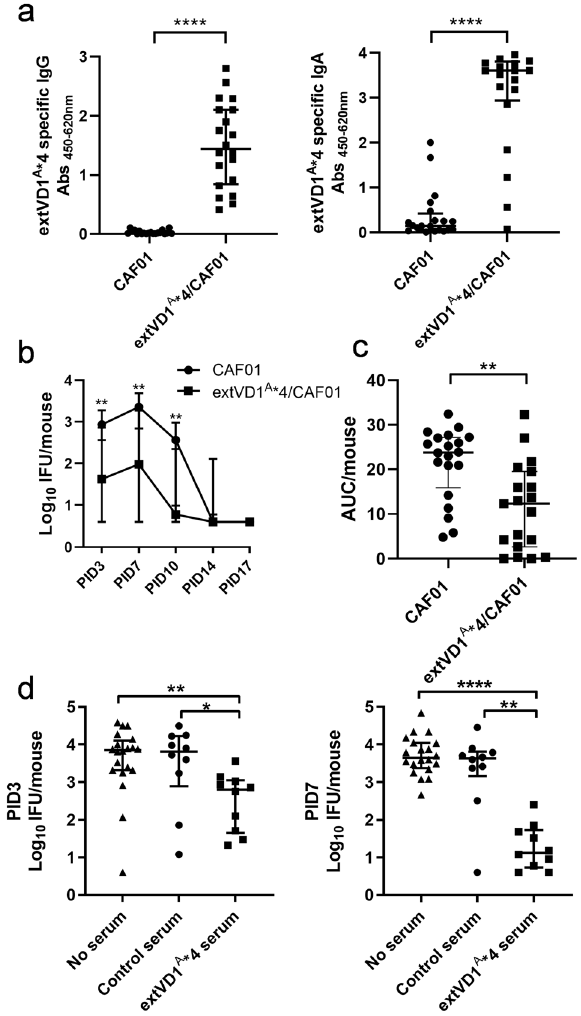
Fig. 4 Protective effect of extVD1 A *4/CAF01 induced immune responses. A/J mice were immunized with extVD1 A *4/CAF01 or CAF01 alone using the SIM vaccination protocol and the results were pooled from two individual experiments ( a – c ). Vaginal wash samples were collected from 20 individual mice/group by fl ushing the vagina with 100 µl of sterile 1× PBS, diluted 15 times, and extVD1 A *4-speci fi c IgG and IgA were measured by ELISA ( a ). Each line indicates median level with 25th and 75th percentiles. A Mann – Whitney test was used for comparison among groups **** p < 0.0001. ExtVD1 A *4/CAF01 ( n = 19) or CAF01 alone ( n = 20) vacci- nated mice were challenged i.vag. 6 weeks post last vaccination with 1 × 10 6 IFU/mouse of SvA/HAR-13 ( b , c ). Data are presented as median log 10 IFU with 25th and 75th percentiles recovered from vaginal swabs at day 3, 7, 10, 14, and 17 post infection (PID) ( b ). A